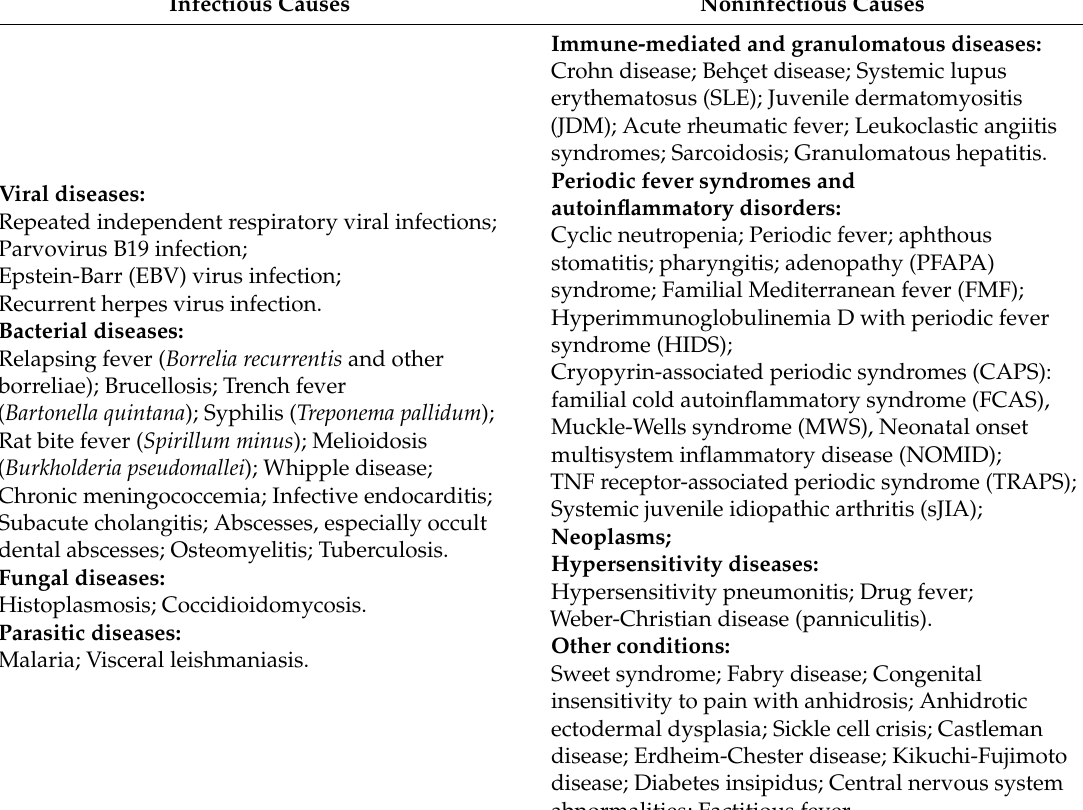
Table 1. Etiology of recurrent fever in